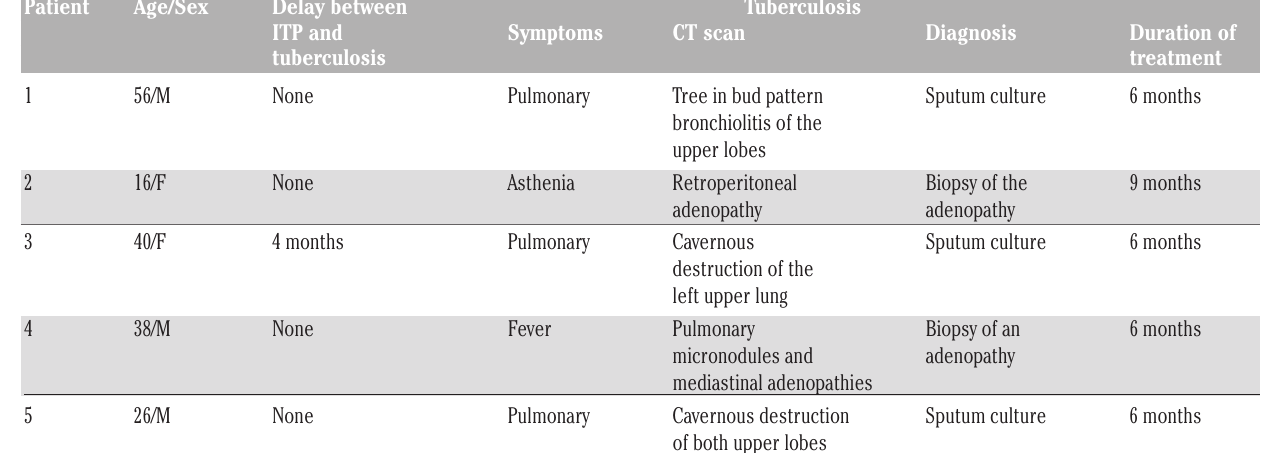
Table 1. Characteristics of the 5 patients with immune thrombocytopenic purpura and tuberculosis.